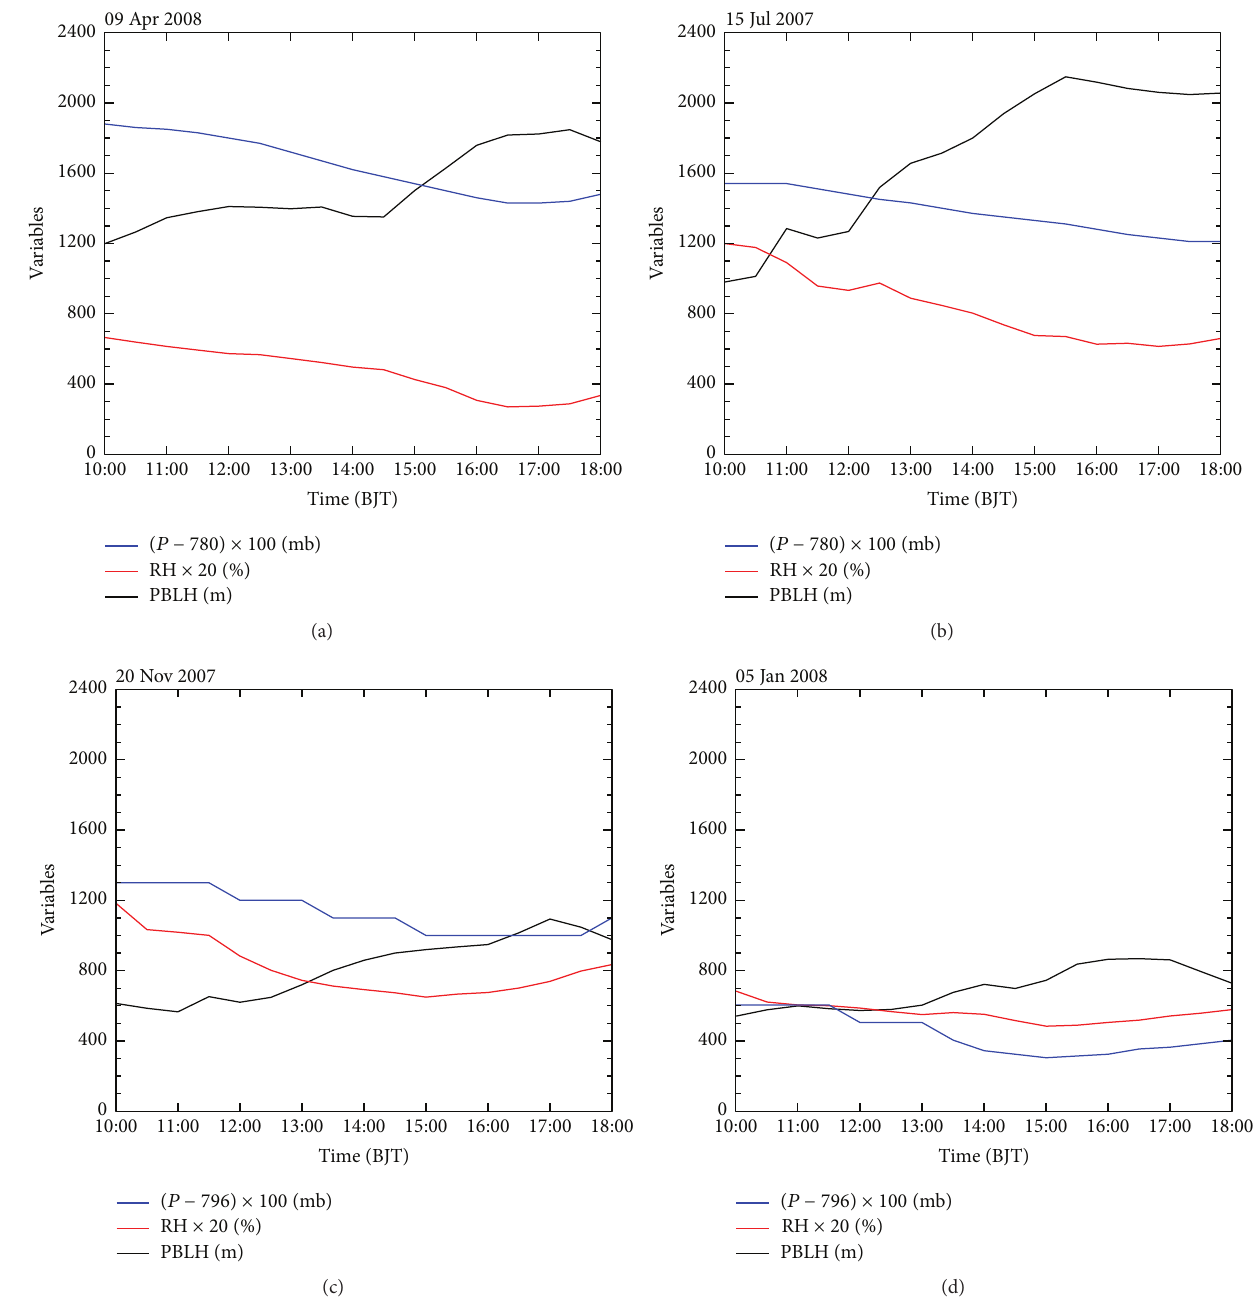
Figure 6: Temporal variations in boundary layer height (PBLH), surface relative humidity (RH), and atmospheric pressure ( 𝑃 ) on (a) 9 April 2008, (b) 15 July 2007, (c) 20 November 2007, and (d) 5 January 2008.